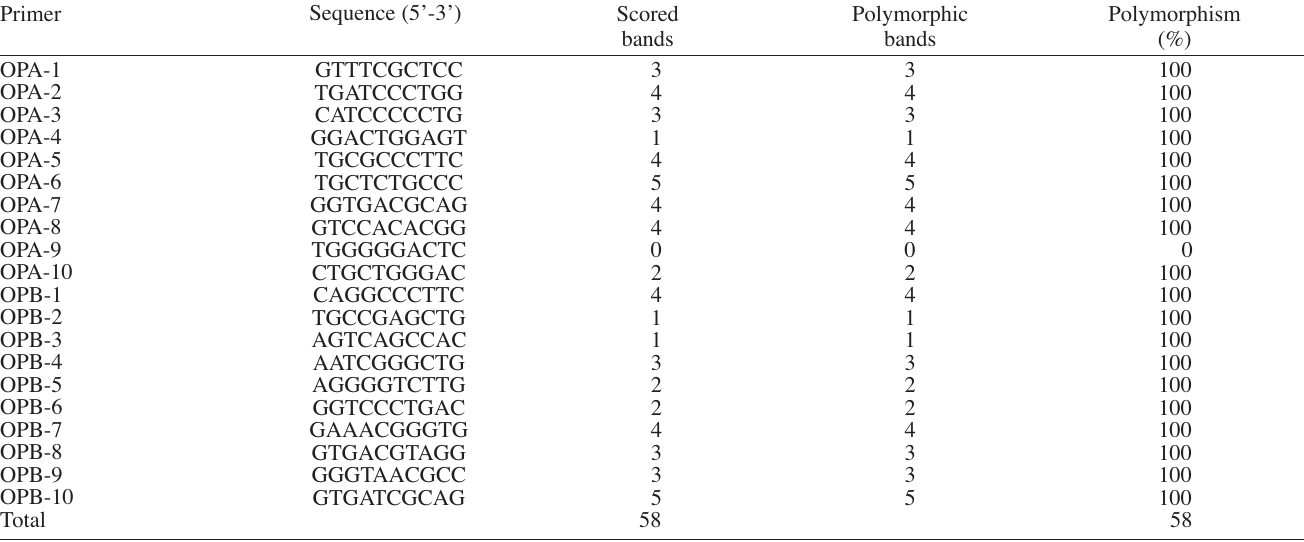
Table 4 - Nucleotide sequences and RAPD amplification results of the primer used in the PCR amplification Primer Sequence (5’-3’) Scored